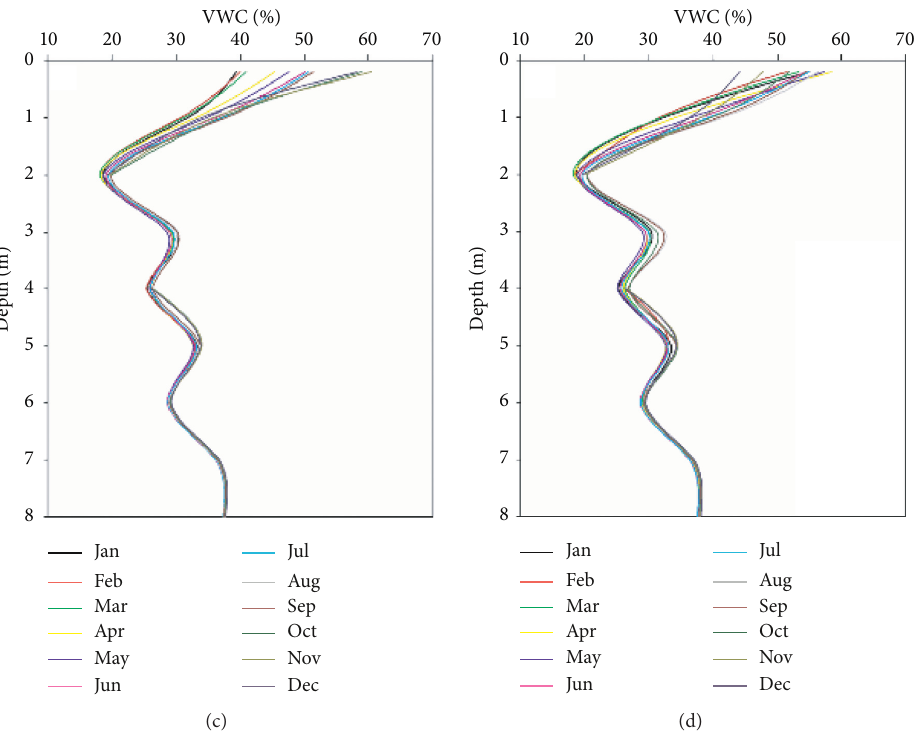
Figure 7: Relationship between VWC and different soil depth in different years on the TDR2 monitoring point: (a) 2009; (b) 2010; (c) 2011; (d) 2012. The other monitoring points data (DTR1, DTR3, and DTR4) are attached in supplementary files (Figures S1–S3).